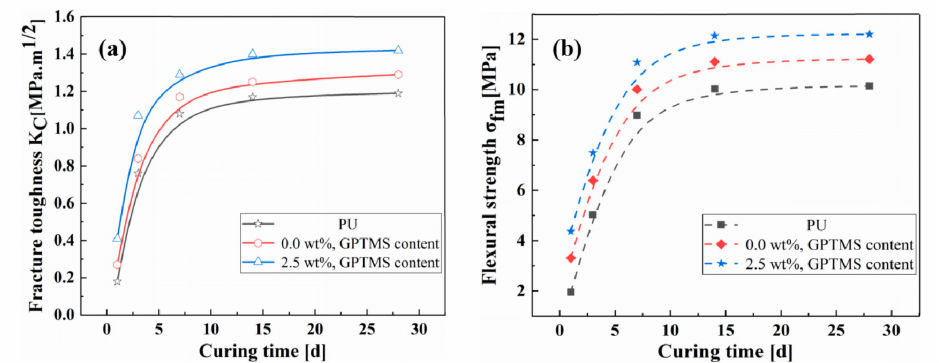
Figure 6. The fracture toughness K c ( a ) and the maximum flexural strengths σ fm ( b ) of PU, PU / MFA-0.0 wt. %, and PU / MFA-2.5 wt. % specimens at di ff erent curing